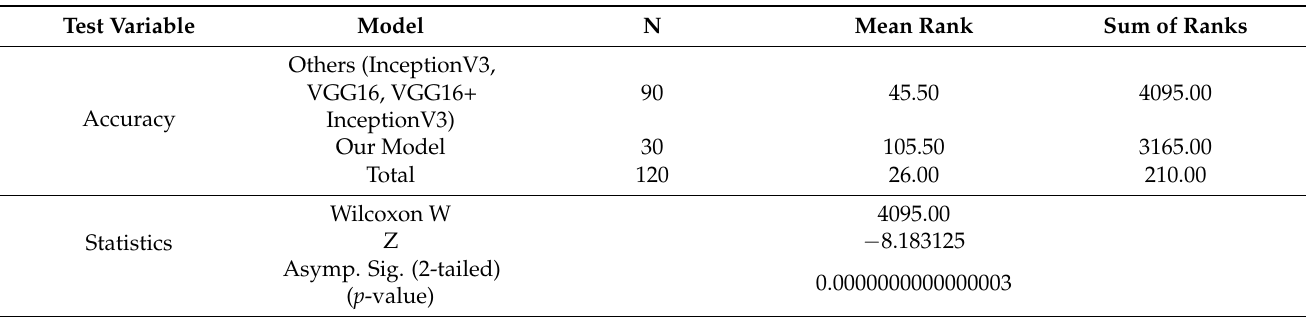
Table 2. Ranks and statistics of proposed model and other models for comparing COVID-19 and Non-COVID-19